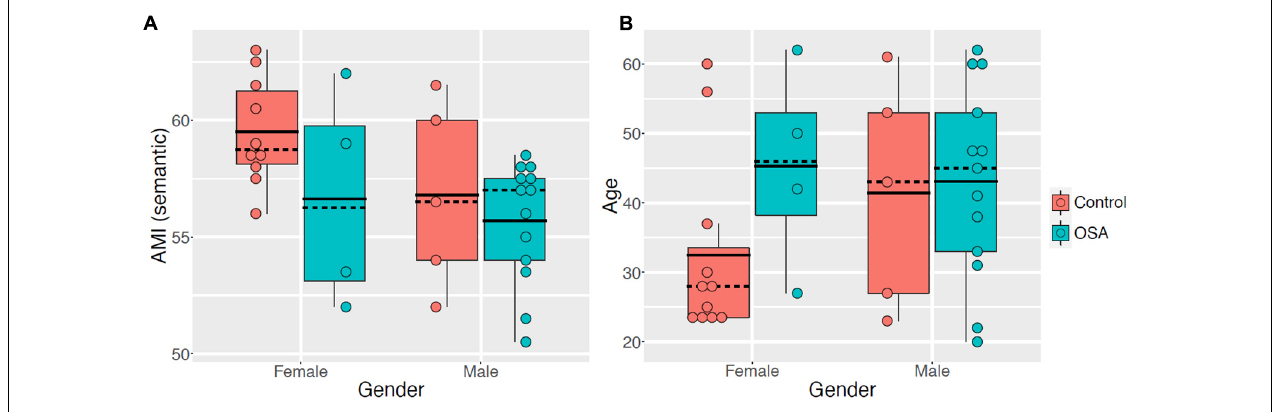
FIGURE 1 | Boxplots, with overlaid dot plots, of (A) AMI semantic scores and (B) age, stratified by sex (Male, Female) and group (Control, OSA).